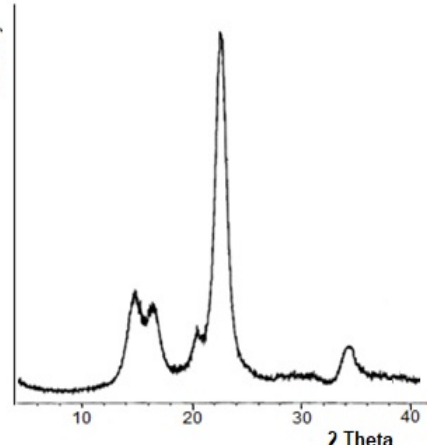
Figure 2. X-ray diffractogram of hydrolyzed cellulose HC-3.